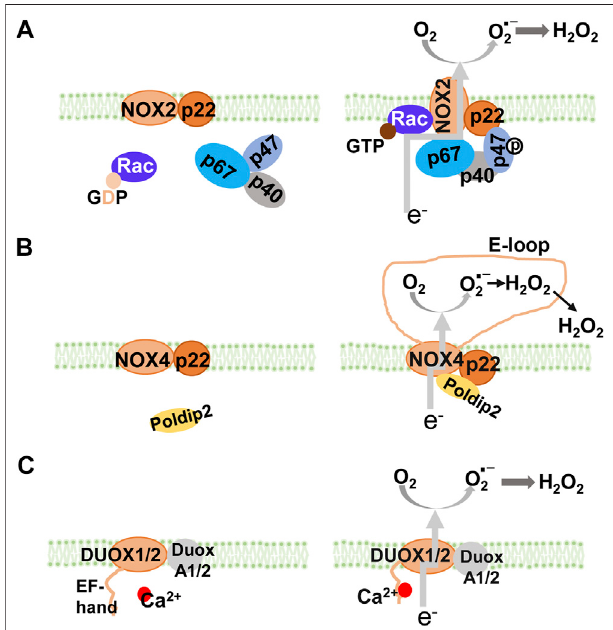
FIGURE 1 | NADPH oxidase isoforms and their assembly. All NOX isoforms have membrane-spanning catalytic subunit that transfers electrons from NADPH through their NADPH and FAD-binding sites and heme groups to reduce O 2 into superoxide anion (A) NOX1, NOX2, and NOX3 are cytosolic activators-dependent with the stabilizing p22 phox membrane subunit. Activation of NOX2 requires assembly with cytosolic p47 phox (equivalent to NoxO1 in NOX1 and NOX3), p67 phox (equivalent to NoxA1 in NOX1 and NOX3), and p40 phox . In resting cells (left panel) , NOX2 and p22 phox are associated, co-stabilizing each other. Upon activation (right panel) , GDP is exchanged for GTP on Rac. The phosphorylation of p47 phox subunit leads to a conformational change, which brings with p67 phox and p40 phox , to form the active NOX2 enzyme complex (NOX1 and NOX3 are not shown) (B) NOX4 is constitutively active with the stabilizing p22 phox membranesubunit.ItsactivitycanbemodulatedbyPoldip2.InsidetheE-loop (3 rd extracellular loop), superoxide is rapidly dismutated into H 2 O 2 (C) NOX5, DUOX1,andDUOX2areCa 2+ dependentwithEF-handdomains.DUOX1and DUOX2 (as well as NOX5, not shown) have Ca 2+ binding domains that undergo conformational change in response to an increase in intracellular Ca 2+ .ItisspeculatedthatactivationofDUOX1,DUOX2,andNOX5,isthrough intramolecular protein-protein interaction between the Ca 2+ -binding domain and the C-terminal catalytic domain. GDP, guanosine diphosphate; GTP, guanosine-5 ′ -triphosphate; NADPH, nicotinamide adenine dinucleotide phosphate; NOX, NADPH